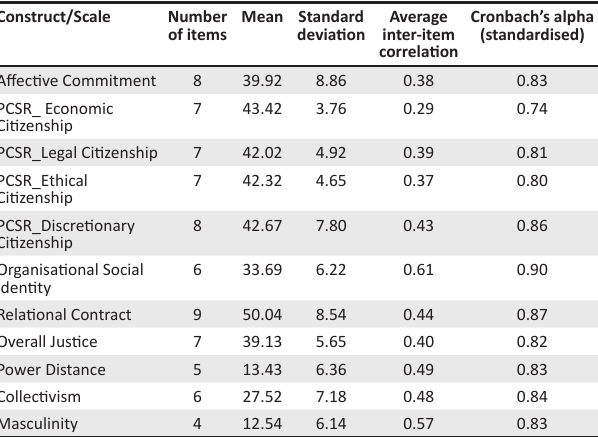
TABLE 1: Summarised reliability analysis of subscales. Construct/Scale Number